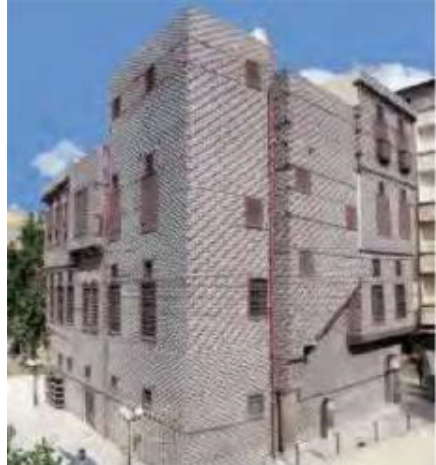
Figure 12. Arab khulli house